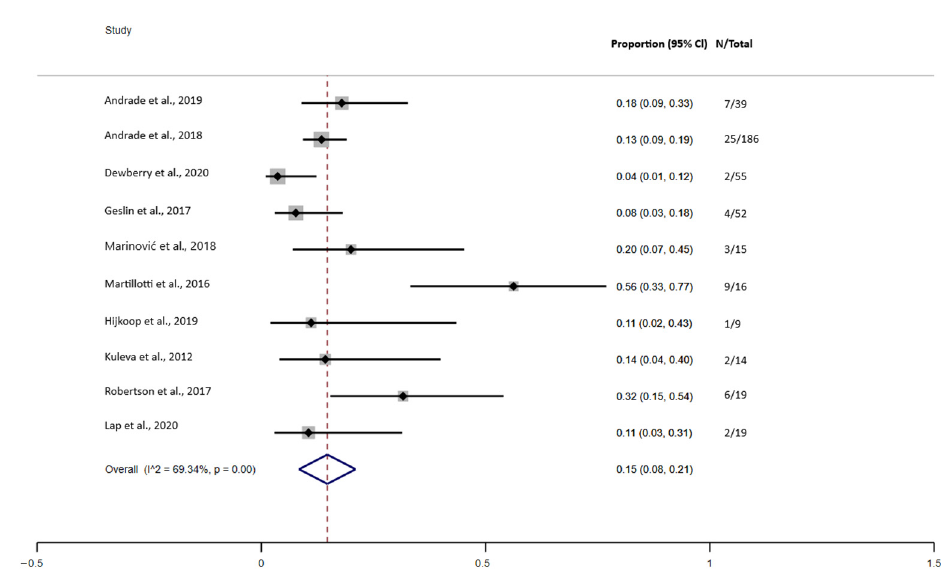
Figure 4. Forest plot of the prevalence of mortality in complex gastroschisis.